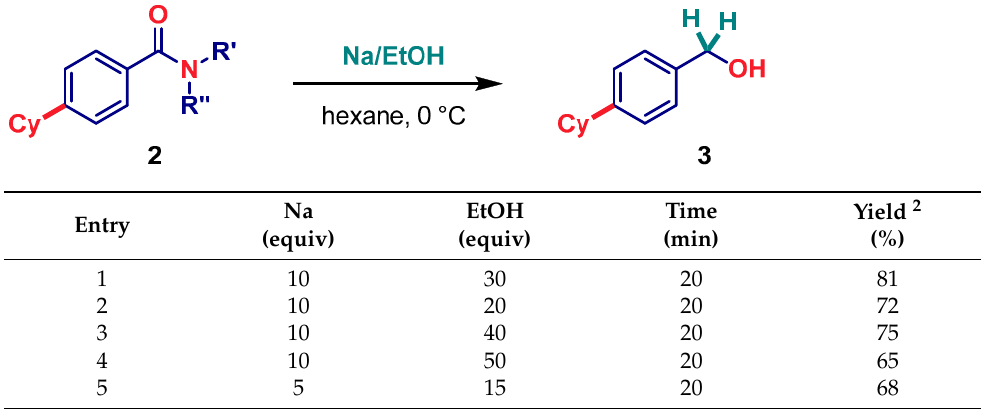
Table 3. Optimization of Sodium Dispersion Mediated Reduction of Aromatic Amides 1 .